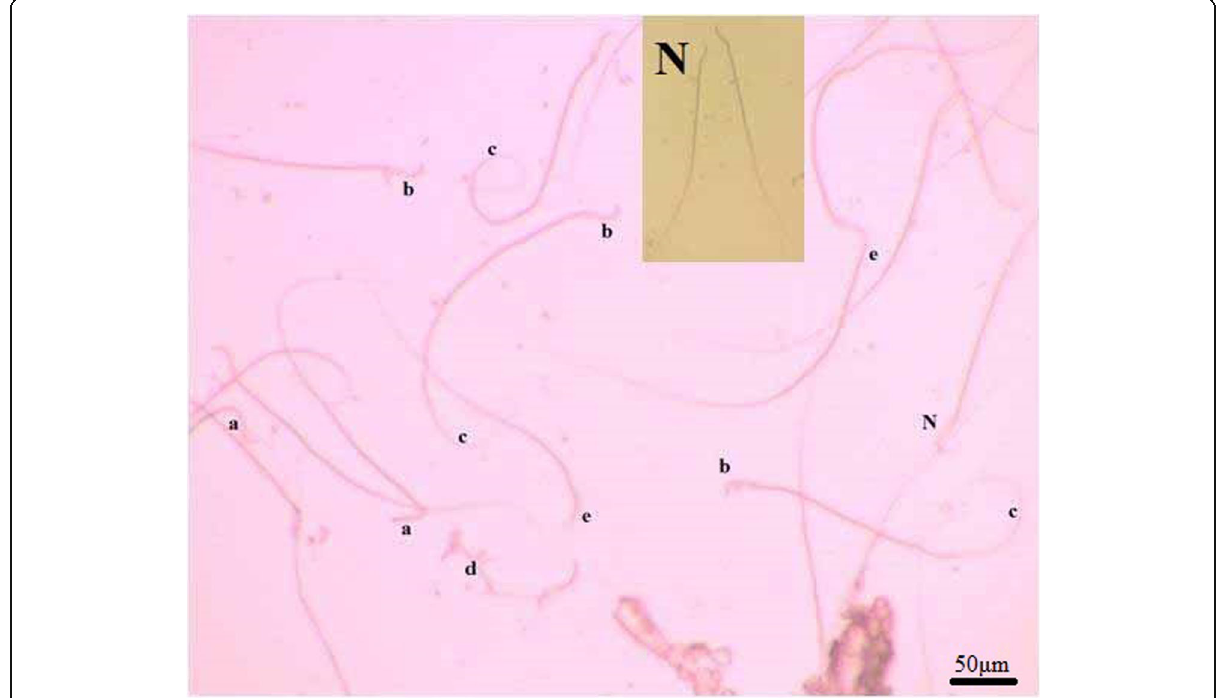
Fig. 1 Photomicrograph showing sperm morphology from the cauda epididymis of male albino rats. (N) normal sperm; (a) bent head; (b) banana head; (c) coiled tail; (d) detached head; (e) headless sperm. Eosin